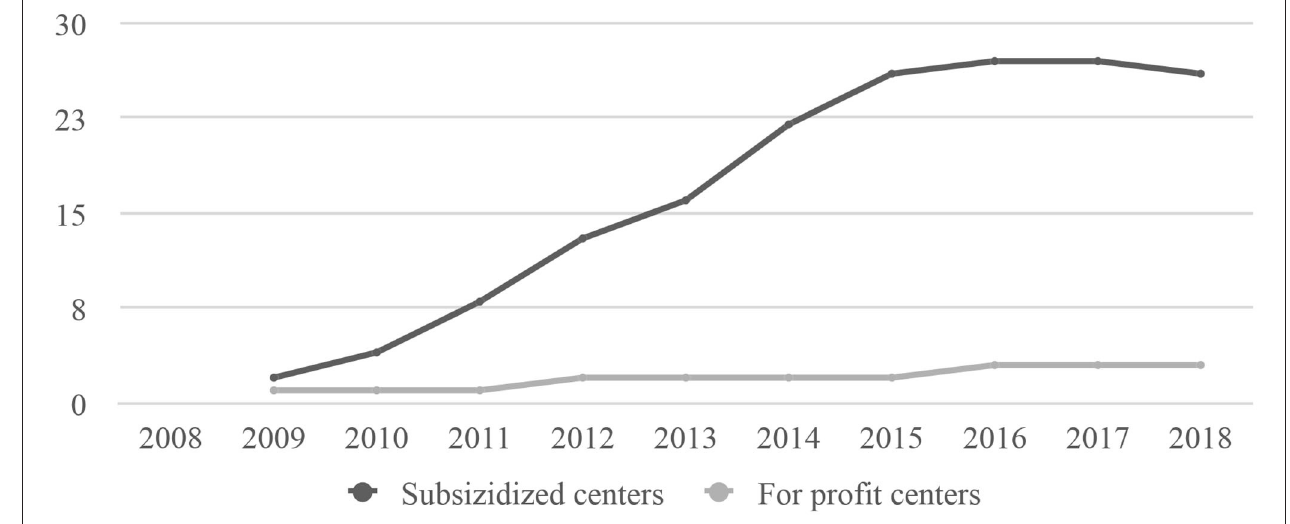
FIGURE 1 | Growth of aeioTU centers by type